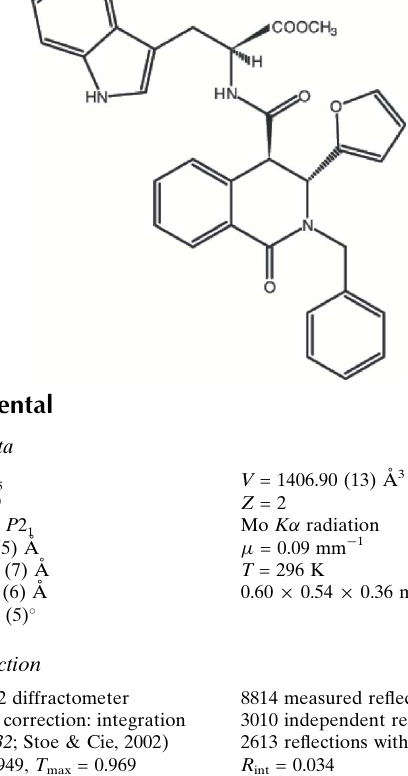
Data collection Stoe IPDS-2 diffractometer Absorption correction: integration